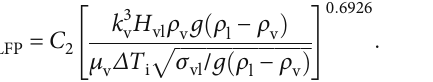
versus p CHF CHF